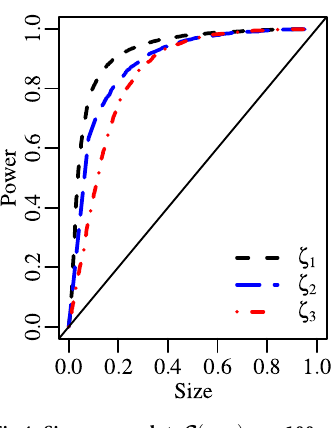
Fig 4. Size-power plot, S ð μ ; σ Þ , n =